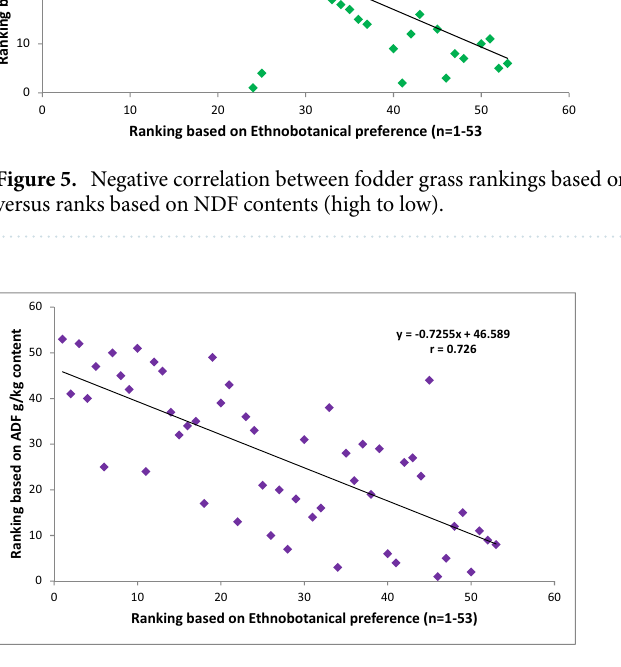
Figure 6. Negative correlation between fodder grass rankings based on ethnobotanical preference ranking versus ranks based on ADF contents (high to